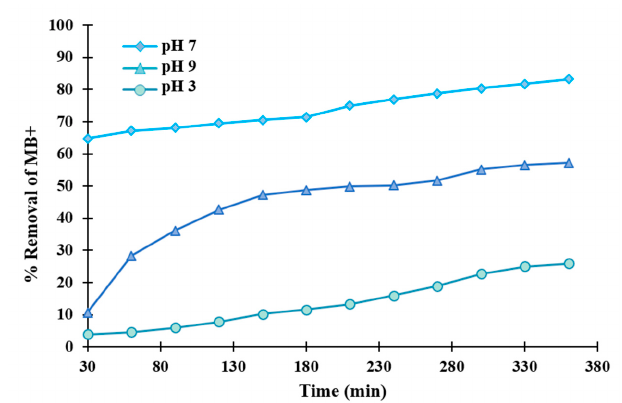
Figure 12. Influence of the pH of the dye solution on removal efficiency in M8 membrane.